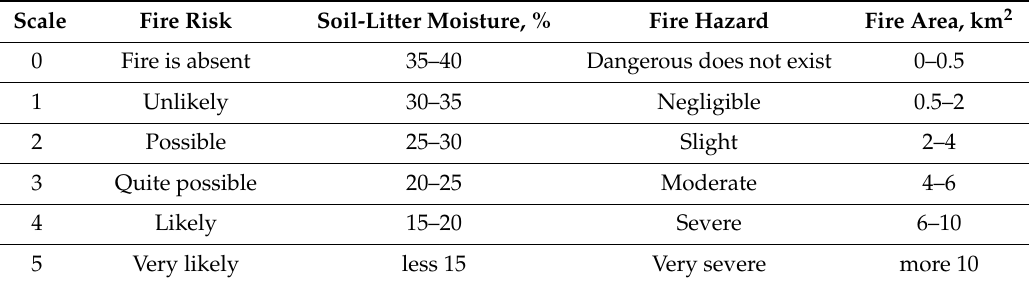
Table 3. Scale of forest fire risk and hazard depending on the fire area and soil-litter moisture.